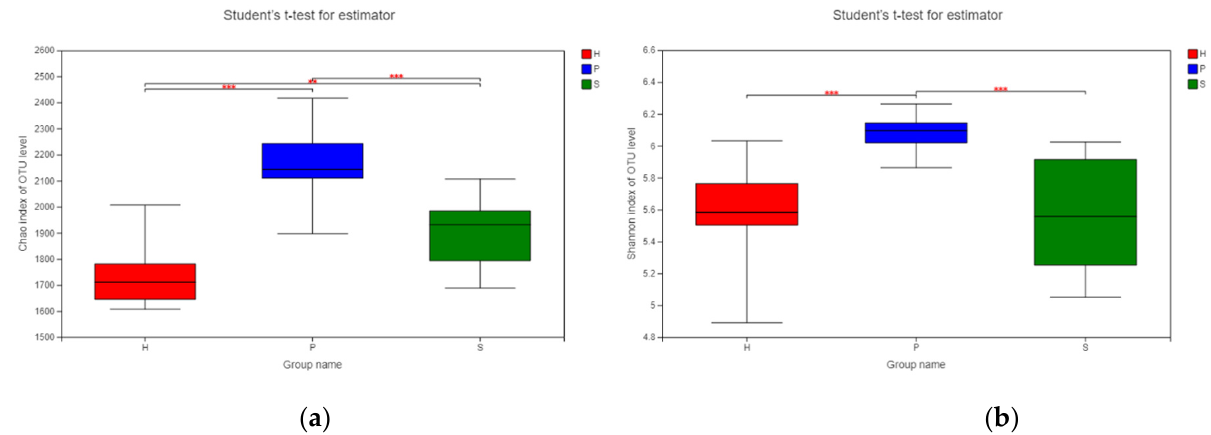
Figure 3. Alpha diversity indices of the fecal microbiota among horses on pasture grass (P, n = 12), silage (S, n = 12), and hay (H, n = 12) dietary patterns. ** p ≤ 0.01, *** p < 0.001. ( a ) Bacterial species richness or Chao index per group of samples. ( b ) Bacterial species diversity or Shannon index per group of samples. Red: group H; blue: group P; green: group S.